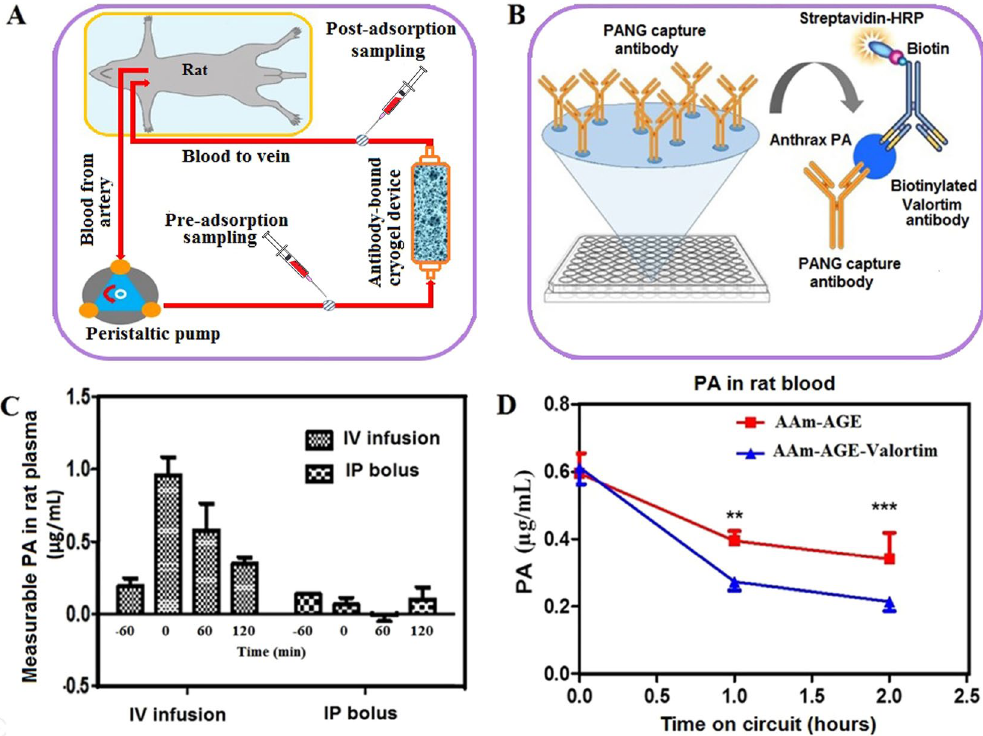
Figure 5. ( A ) An ex vivo extracorporeal circuit incorporating cryogel columns. ( B ) The principle of the anti-PA sandwich ELISA used to measure plasma PA concentrations of PA left in a rat blood. ( C ) Measurable rat plasma PA concentrations immediately after administration by IV infusion (time = − 60 minutes) or IP